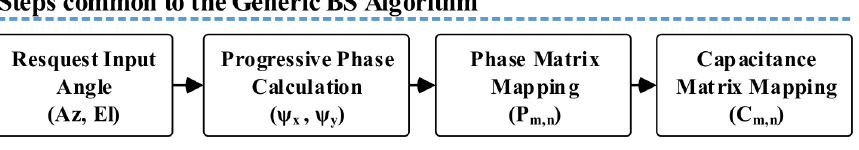
Figure 4. Simulated and measured S 2,1